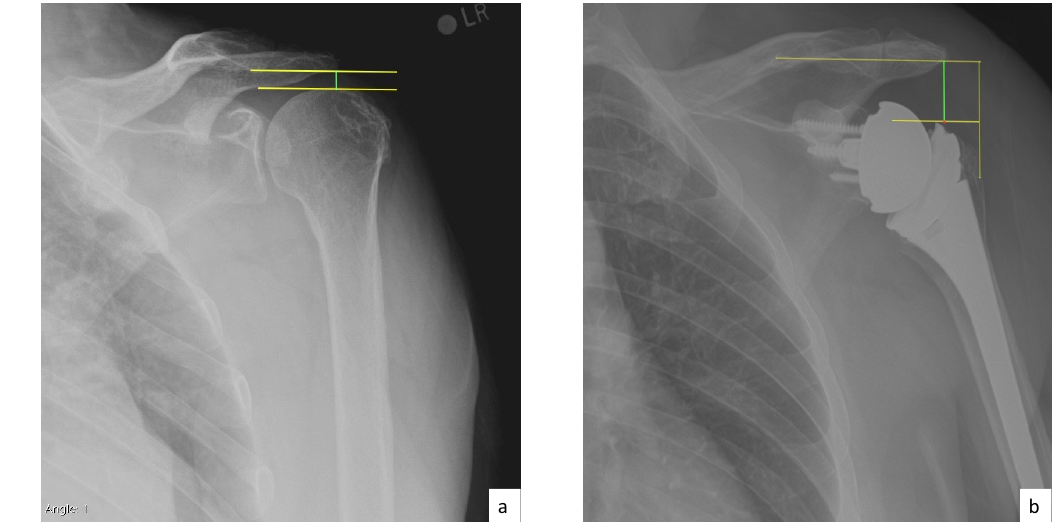
Figure 1. ( a ) Preoperative acromiohumeral distance (AHD; green line); ( b ) postoperative acromiohumeral distance (AHD; green line).